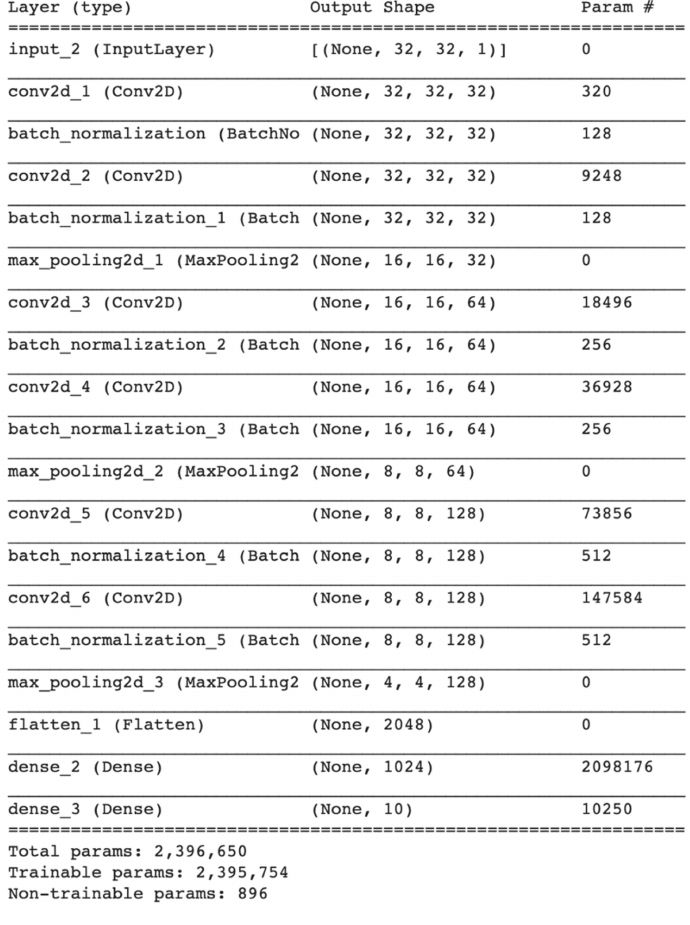
Figure A6. Advanced Model CNN Structure Parameters